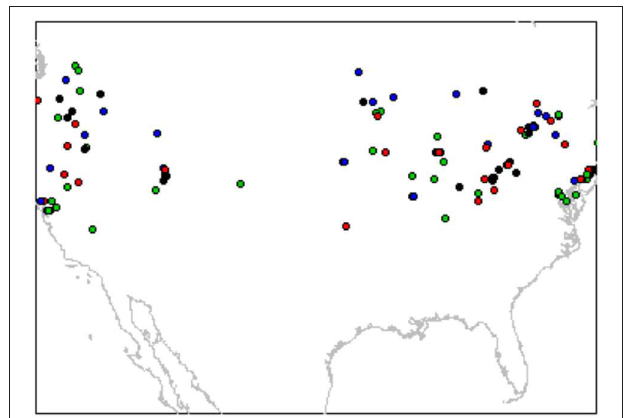
FIGURE 2 | Partition of monarch butterfly localities from compiled records into four bins (different colors) by the “checkerboard2” method to train and test the models (See Methods for